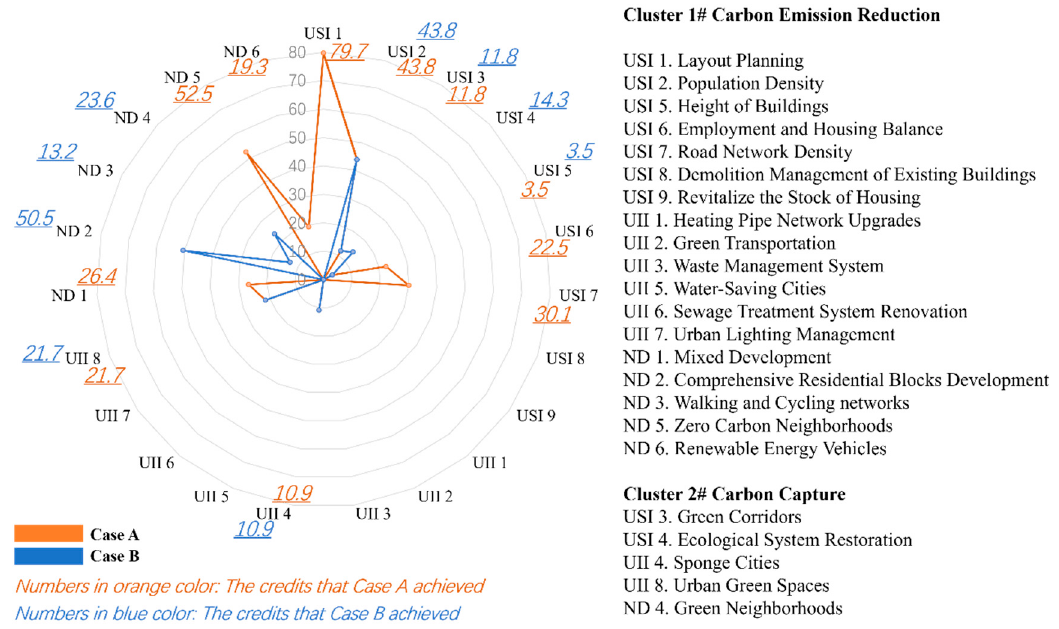
Figure 8. Comparisons of credit distributions of Case A and Case B. Note: The acquisition of credits for indicators in the radar chart was based on achievement, instead of performance; for details of the score table, see Table 11.